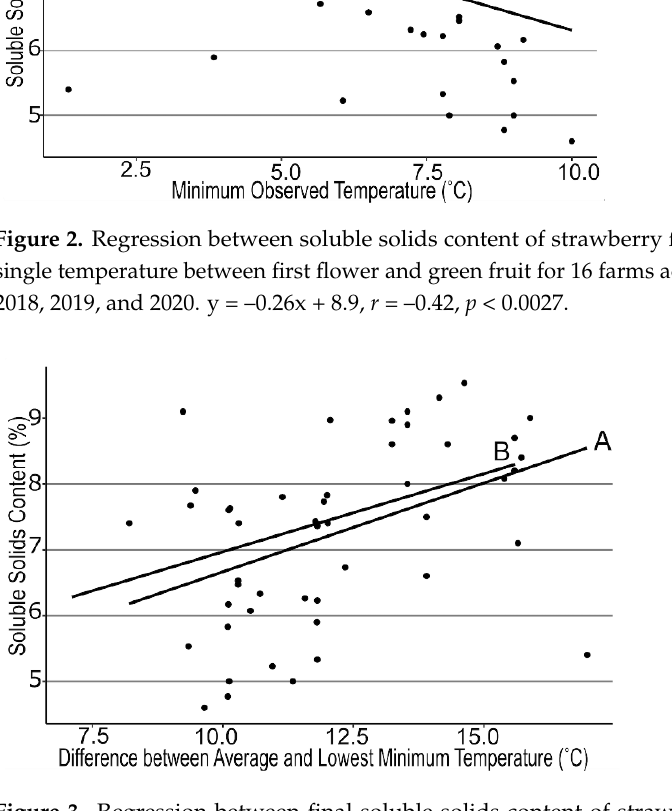
Figure 4. Regression between titratable acidity of strawberry fruit at harvest and the difference between mean air temperature and the lowest single temperature between first flower and green fruit (A) and green to pink fruit (B) for 16 farms across New York State visited in 2018, 2019, and 2020. A: y = 0.37x − 2.8, r = 0.7, p < 0.0001. B: y = 0.38x − 2.6, r = 0.74, p < 0.0001. The relative importance of year-to-year variation and farm – to-farm variation was de- termined by examining the coefficients of variation (CV) of the measured variables. The CV of the population of differences from one year to the next on the same farm (70 – 360% for SSC; 34 – 49% for TA) was much larger than the CV of the population of differences among farms in the same year (12 – 18% for SSC; 11 – 25% for TA). Furthermore, SSC and TA levels increased or decreased in a consistent direction from one year to the next across all farms (Figures 5 and 6). Accumulated GDD and rainfall from 1 April were either weakly or not consistently correlated with SSC or TA. SSC and TA were significantly dif- ferent between years when treating farm site as a replicate ( p < 0.05, <0.0001, respectively), but the effect of farm site was not significant when treating year as a replicate ( p > 0.3, p > 0.9, respectively).